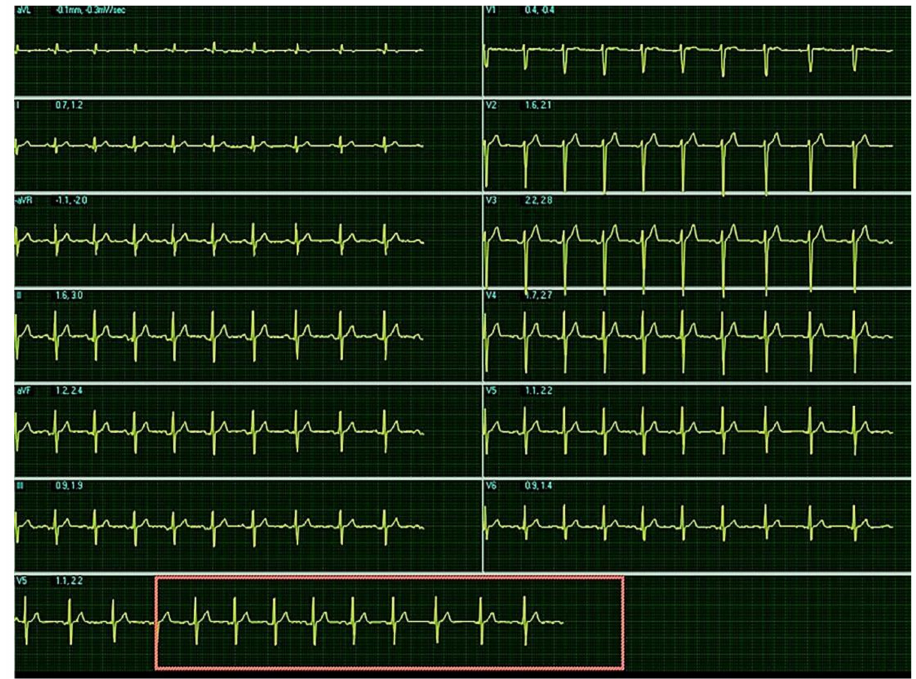
Figure 2. Baseline ECG before the cardiopulmonary test: sinus rhythm, heartrate = 80/min, AxQRS + 70, narrow QRS complex, R/S in leads D2, D3, aVF, r/S in leads V2, V3 without signs of hypertrophy.